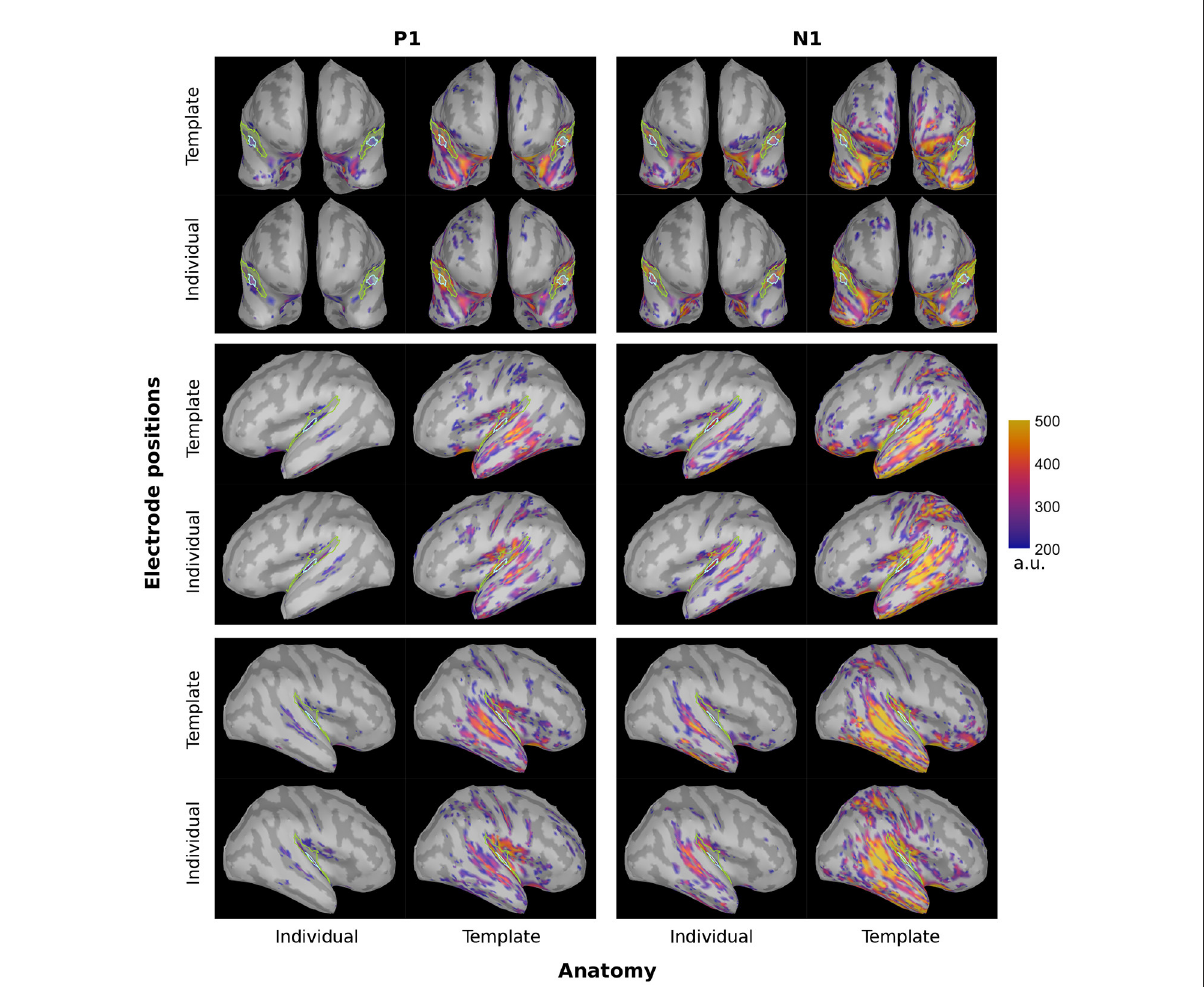
FIGURE5 sLORETA brainmaps depicting the PAC activation at the P1 ( ∼ 55 ms, top) and N1 ( ∼ 100 ms, bottom) timing for both hemispheres and all considered configurations. For display, no minimal cluster size was set and the minimum amplitude was set at 20% of the maximum activation across all four configurations of the inverse solution. Cyan: atlas-defined PAC; Green: extended